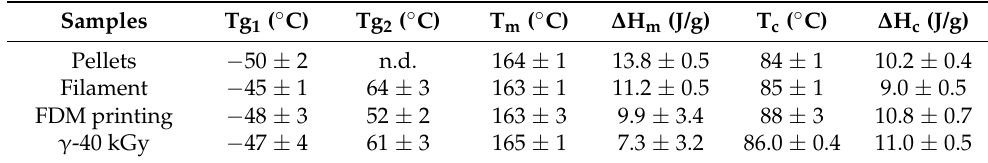
Figure 3. DSC traces from first heating run ( a ) and cooling run ( b ) for the raw pellets, extruded filament, FDM processed and sterilized samples. Table 2. Collected DSC data (n = 3) from first cycle (mean ± SD).